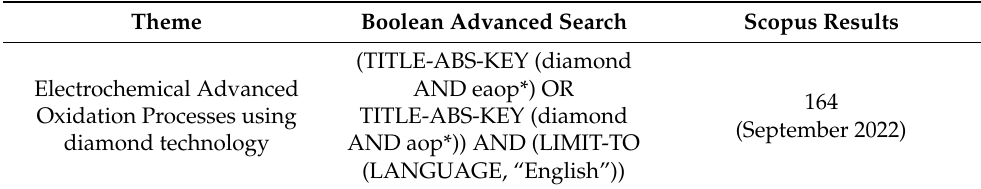
Figure 2. Venn diagram representing EAOP combinations from the first SLR test sample (source: the authors). Table 2. Details of the Boolean advanced search query: theme, strings, search query, and results, based on the Scopus database (source: the